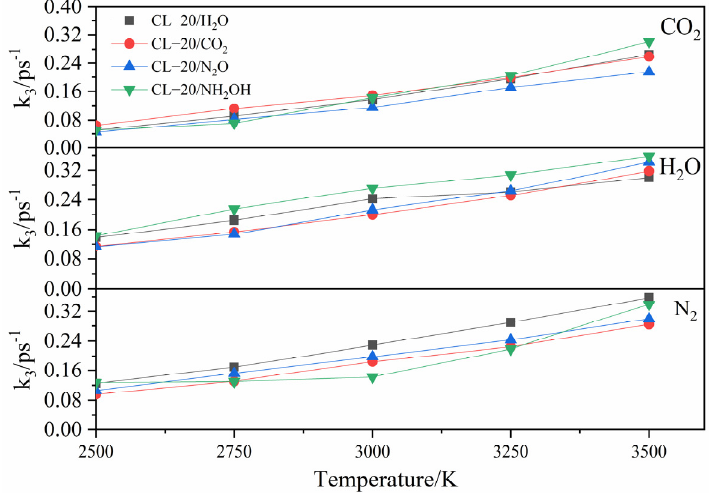
Figure 15. Comparison of the k 3 values of CO 2 , H 2 O and N 2 for CL-20/H 2 O, CL-20/CO 2 , CL-20/N 2 O, CL-20/NH 2 OH at different temperatures. Thick trendline corresponds to the actual concentration data of corresponding matching color.